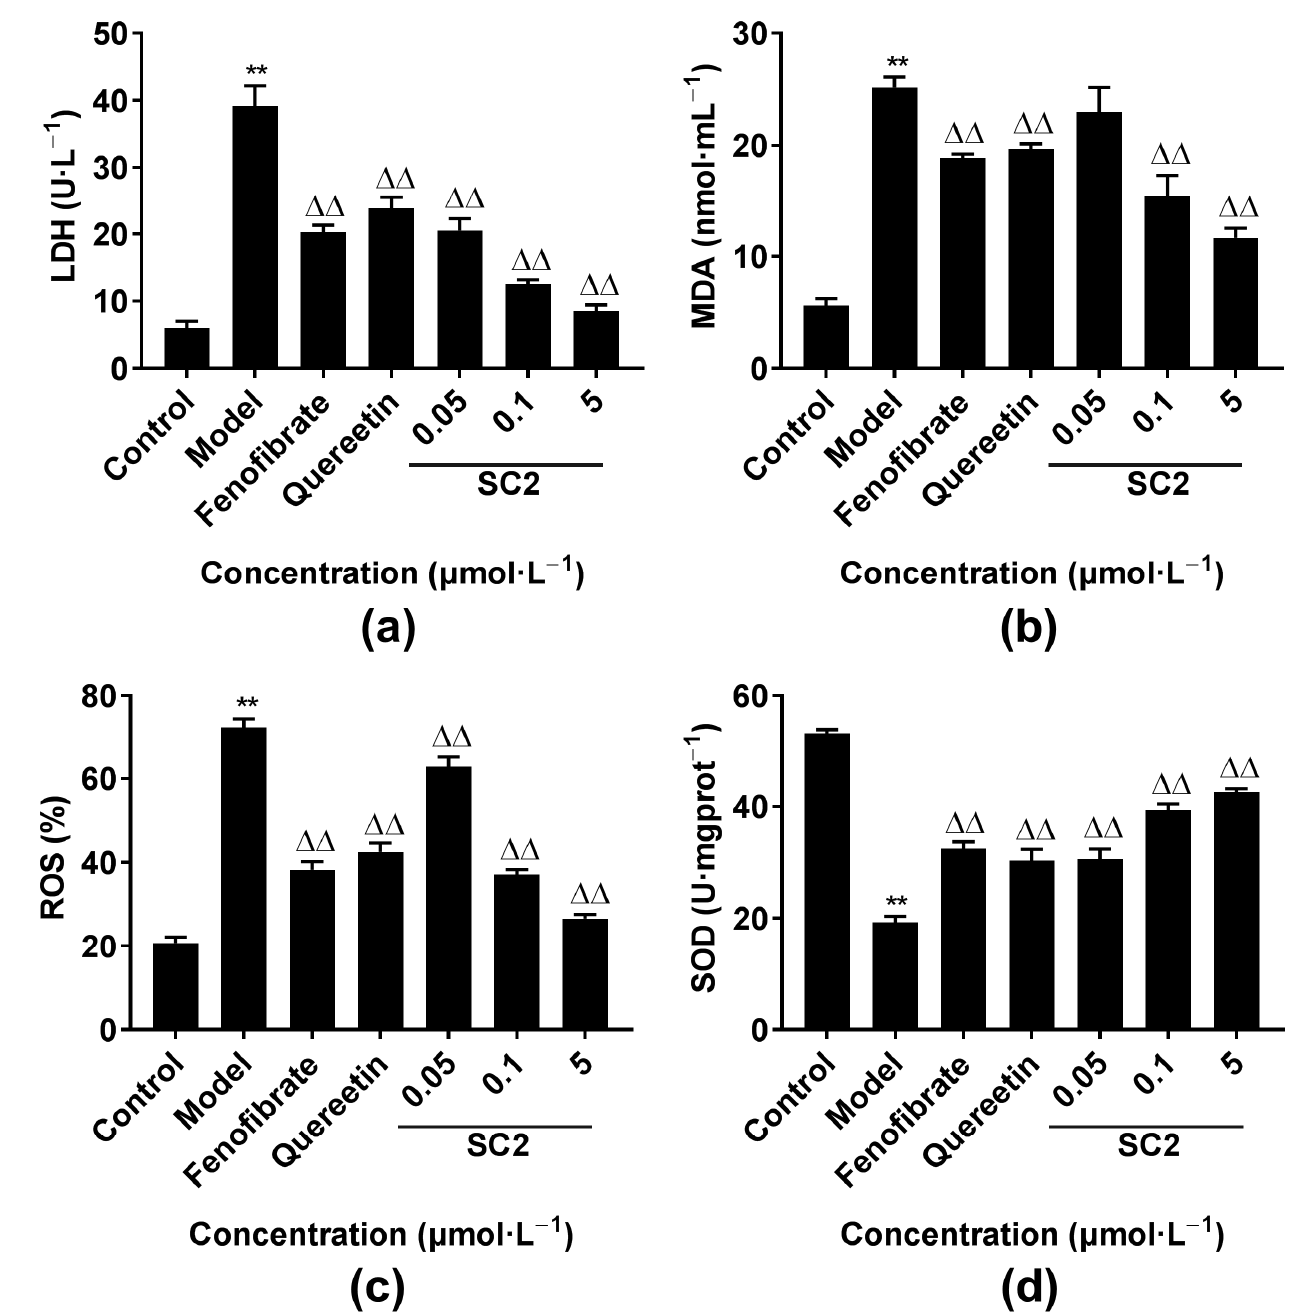
Figure 9. Improved biochemical indicators in compound SC2-treated group caused by oxidative stress damage. ( a ) Lactate dehydrogenase (LDH) content; ( b ) Malondialdehyde (MDA) content; ( c ) Reactive oxygen species (ROS) content; ( d ) Superoxide dismutase (SOD) activity (compared with that in the control group, ** p < 0.01; compared with that in the model group, △△ p < 0.01).